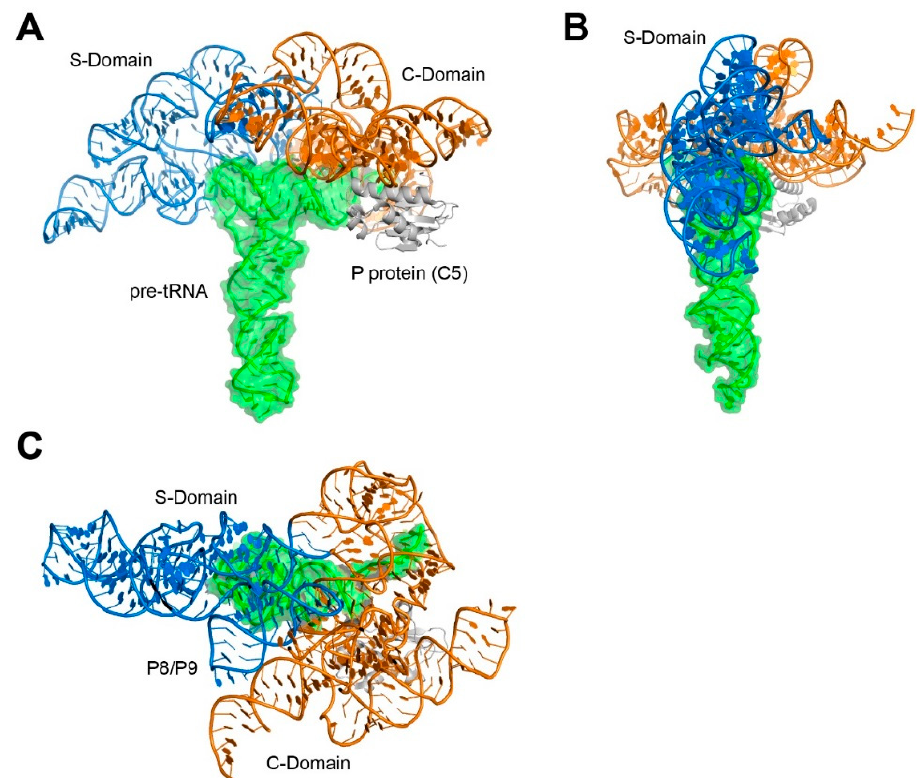
Figure 2. Structure of a bacterial RNase P holoenzyme in complex with its pre ‐ tRNA substrate. ( A ) Front view; ( B ) side view; and ( C ) top view. PDB ID: 3Q1Q [15]. All molecular graphics were generated with PyMol [18].